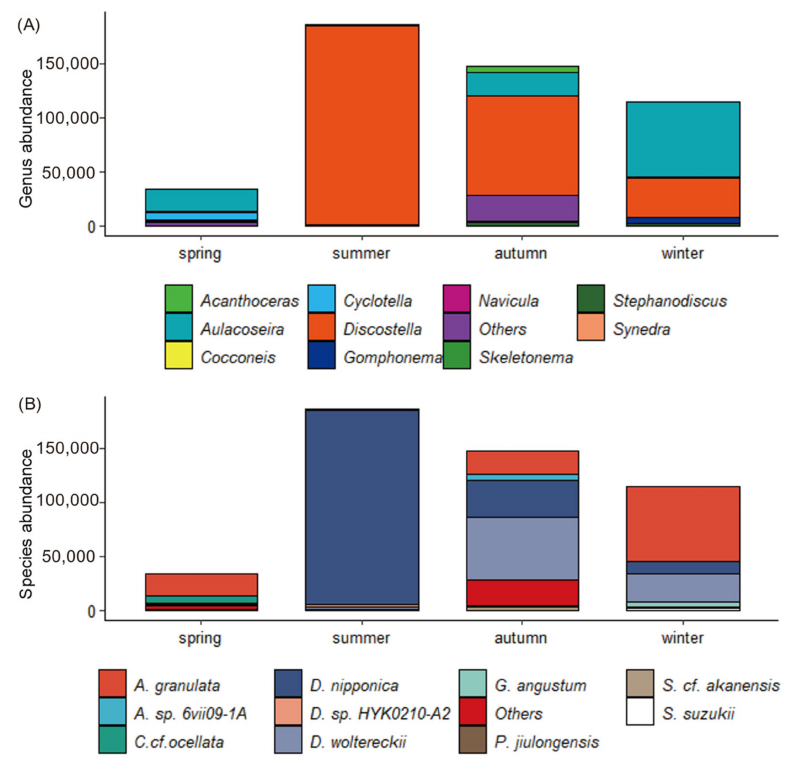
Figure 2. Seasonal distribution of diatom communities at genus and species levels in Danjiangkou Reservoir (( A ) is genus and ( B ) is species).